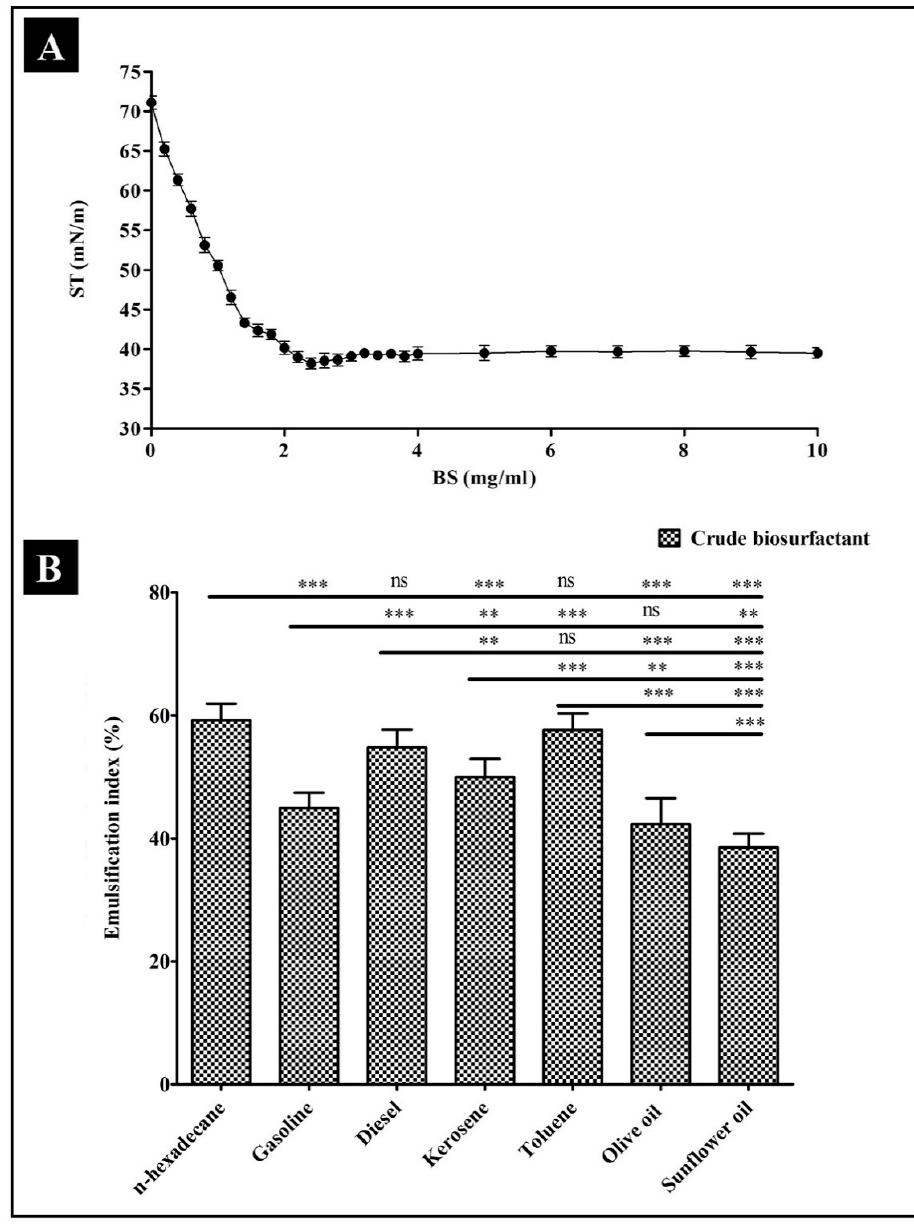
Figure 3. Results of the physical properties of P. pentosaceus crude biosurfactant (BS). ( A ) Progressive decrease in surface tension (ST) with an increase in the concentration of the biosurfactant up to 2.4 g/L. ( B ) %E24 of the cell-bound biosurfactant against different substrates. Values are represented as mean ± SD of three independent experiments. Significance; ns > 0.05, * p < 0.05, ** p < 0.005, *** p < 0.0005.